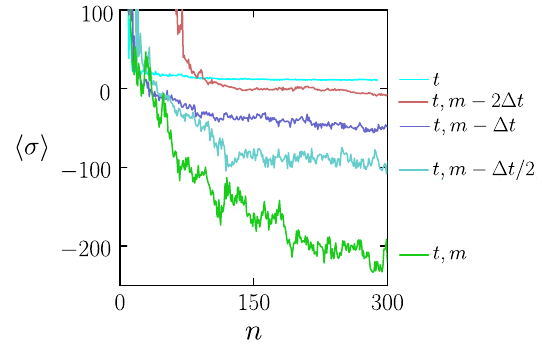
7. Supplement to Fig. 3. Similar to Fig. 3(d) (with the demon trained using time alone), showing the GA result of that figure (green) against five results obtained using aMC as a method of training (gray). The horizontal axes of panels (a) and (b) denote the number of epochs (training cycles) and number of evaluations of the loss function (proportional to the number of trajectories run), respectively. GA is particularly convenient if trajectories can be run in batches or in parallel. In this example, aMC and GA converge similarly quickly per